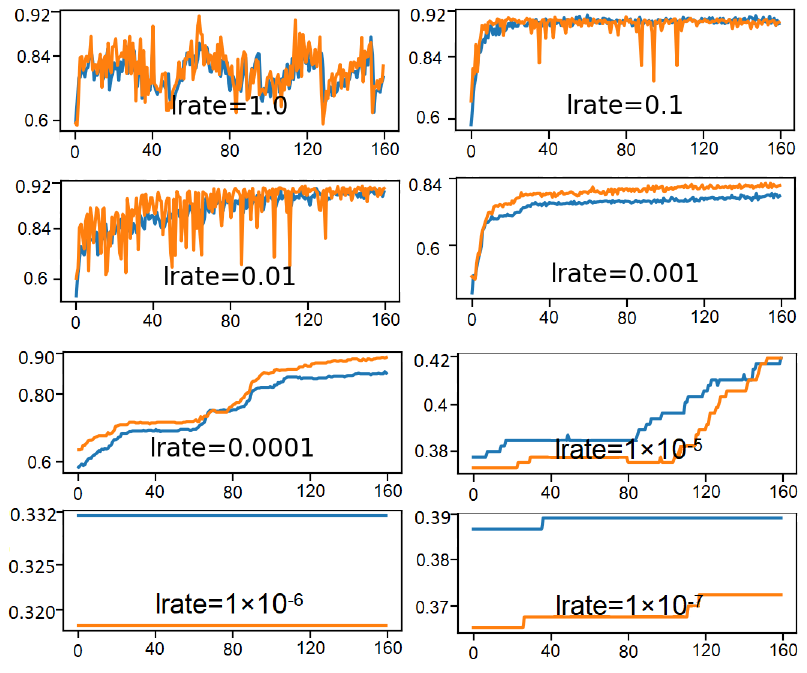
Figure 20. DDQN hyper-parameter tuning for learning